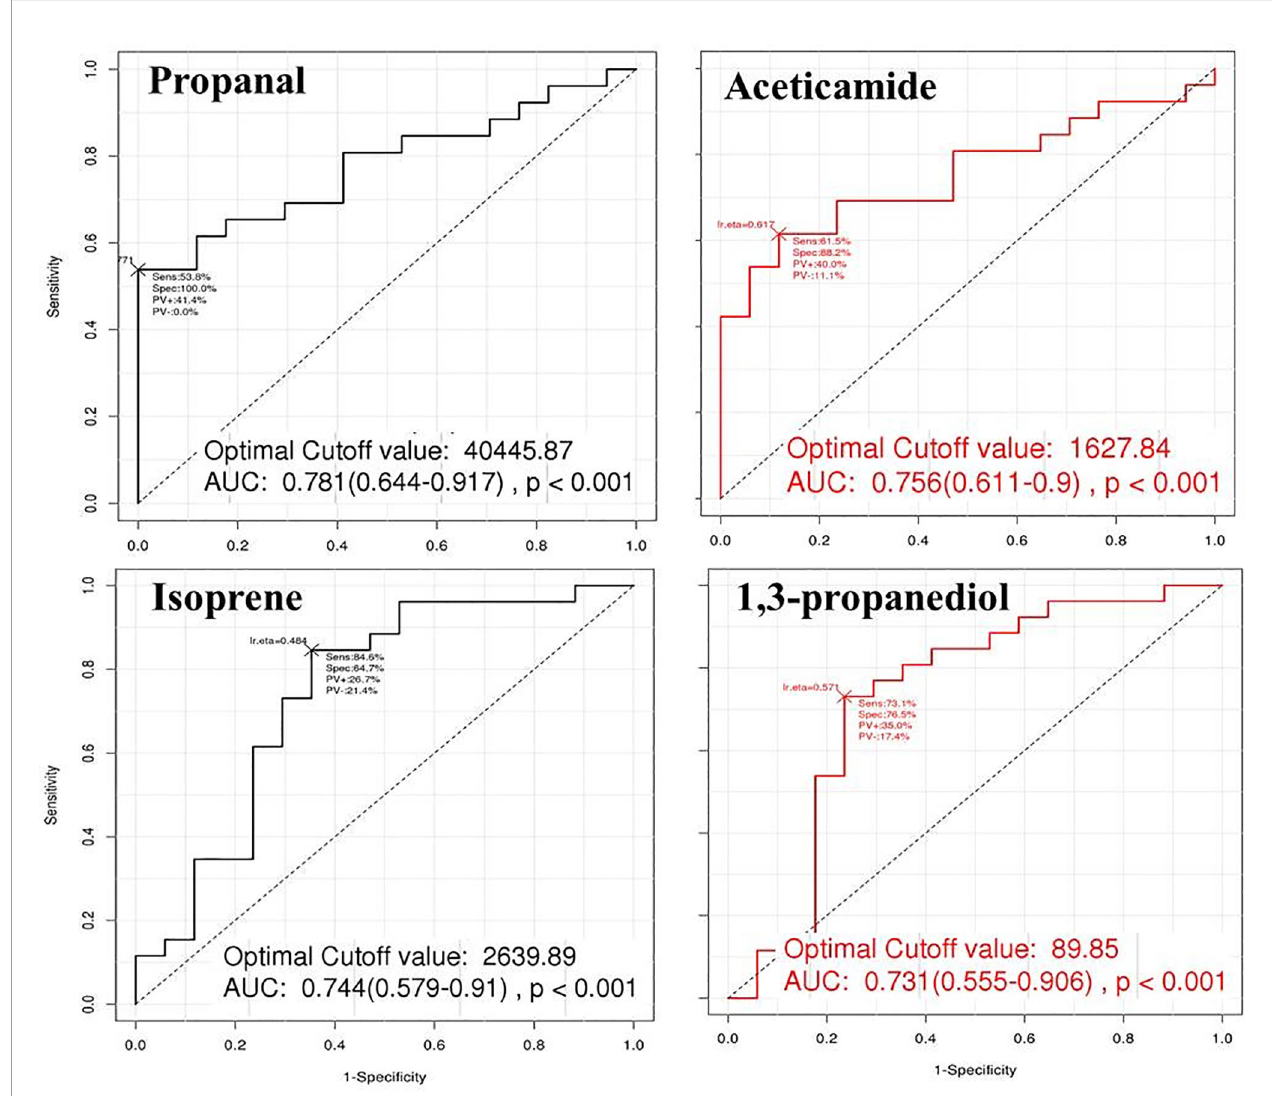
FIGURE 3 | The Receiver operating characteristic (ROC) curves for the effectiveness of volatile organic compounds (VOCs) to predict gastric cancer. The ROC curves were constructed for the four VOCs that increased with cancer stage. The areas under the curve (AUC) for gastric cancer prediction ranged from 0.731 to 0.781 among the VOCs. Propanal showed highest level of AUC of 0.781 with cutoff value of 40 445.87 cps.